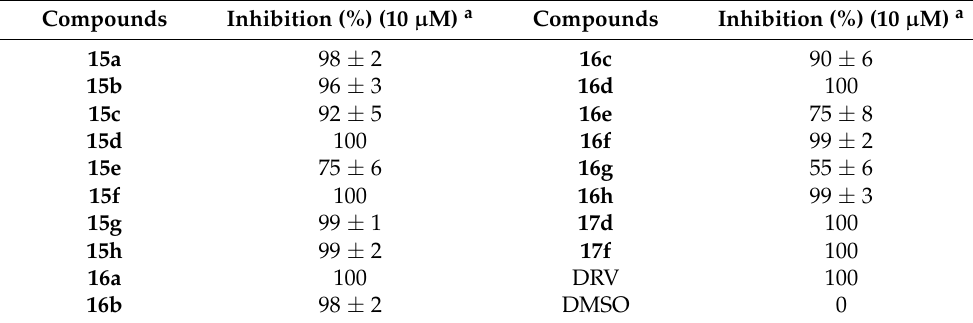
Table 2. Effects of inhibitors on late-stage HIV-1.